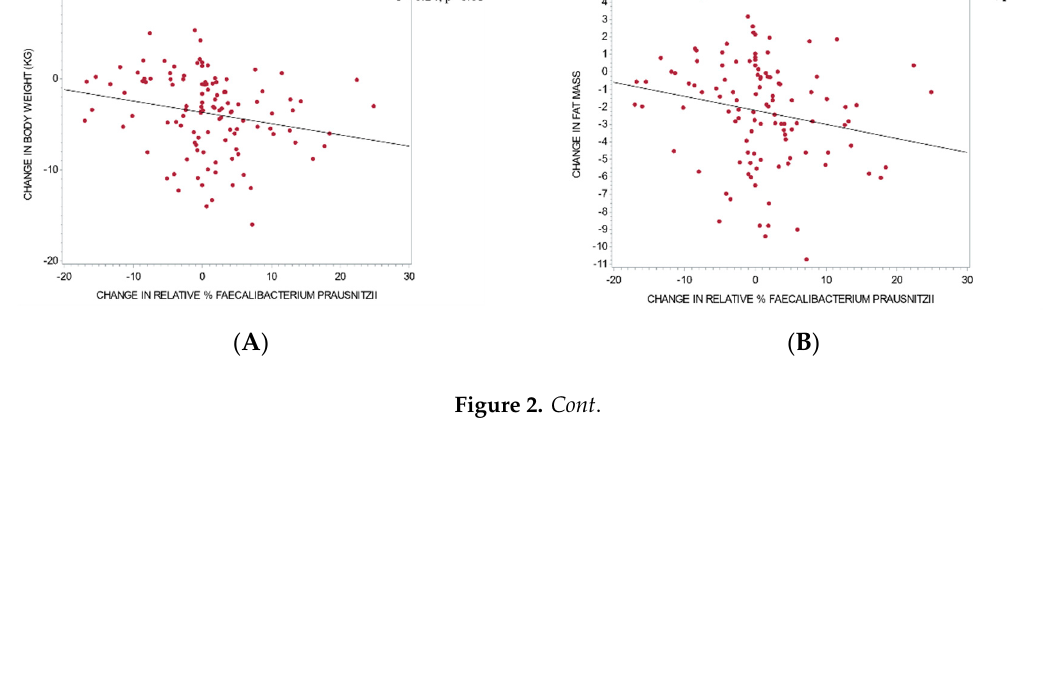
( F ) Figure 2. Correlations between changes in relative abundance of gut bacteria and changes in metabolic outcomes: Correlations between changes in relative abundance of Faecalibacterium prausnitzii and changes in body weight ( A ), fat mass ( B ), and visceral fat ( C ); and correlations between changes in the relative abundance of Bacteroides fragilis and changes in body weight ( D ), fat mass ( E ), and visceral fat ( F ). 4. Discussion In this randomized trial, a low-fat vegan diet led to a significant reduction in body weight, primarily reflecting a reduction in fat mass and in visceral fat volume and a significant increase in insulin sensitivity. An increase in the relative abundance of Faecalibacterium prausnitzii in the vegan group and a smaller decrease in the relative abundance of Bacteroides fragilis in the vegan group,